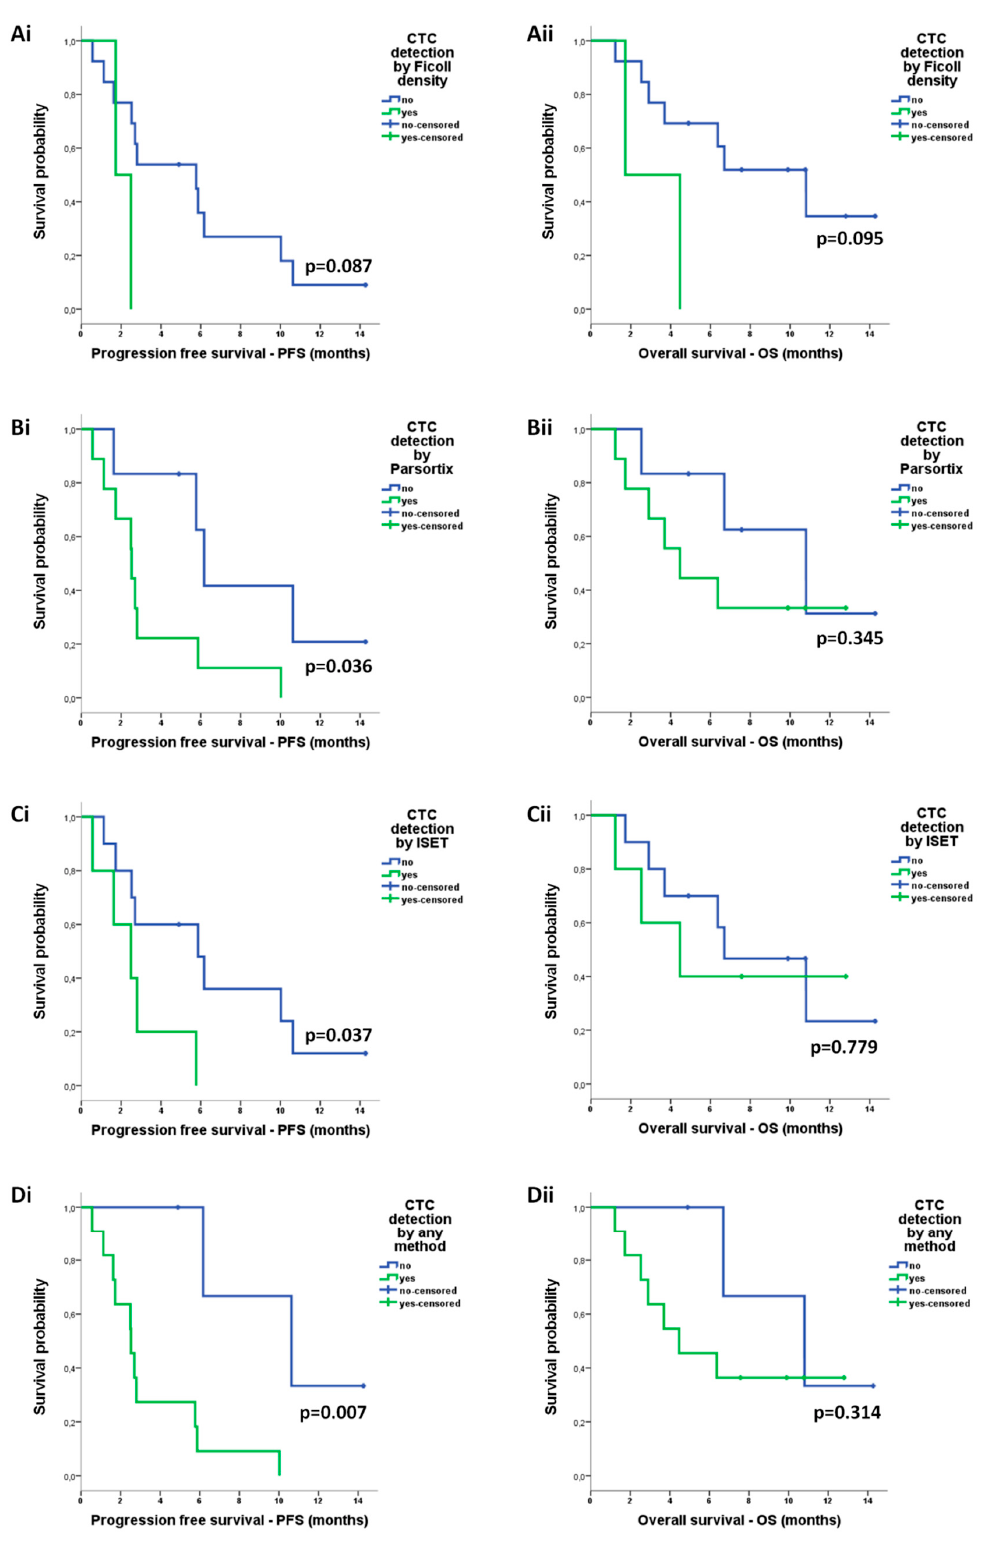
Figure 6. Prognostic relevance of circulating tumor cells (CTCs) enriched by different approaches in patients with non ‐ small cell lung cancer (NSCLC): Kaplan–Meier analysis of progression ‐ free survival (PFS) and overall survival (OS) according to the detection of CTCs after enrichment using ( Ai,ii ) ficoll density, ( Bi,ii ) ISET, ( Ci,ii ) Parsortix, and ( Di,ii ) any